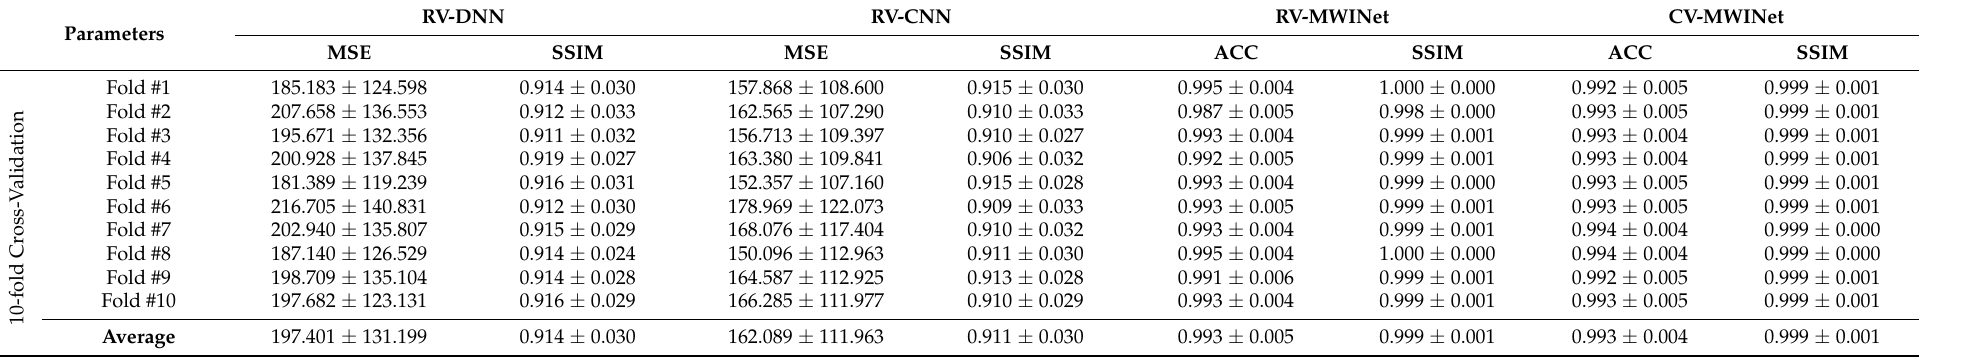
Table 4. Performance metrics of the proposed neurocomputational models for 10-fold cross-validation using test